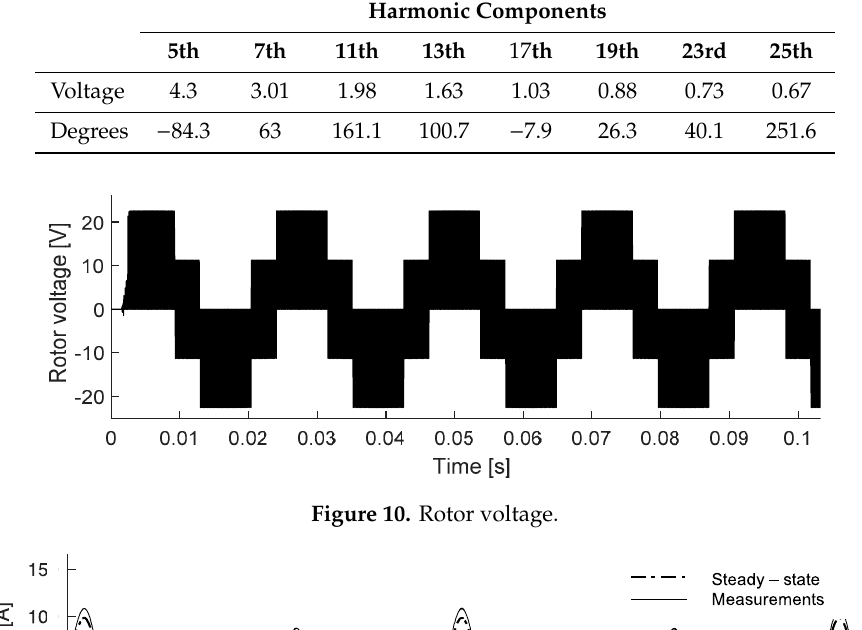
Figure 10. Rotor voltage. Appl. Sci. 2020 , 10 , x FOR PEER REVIEW